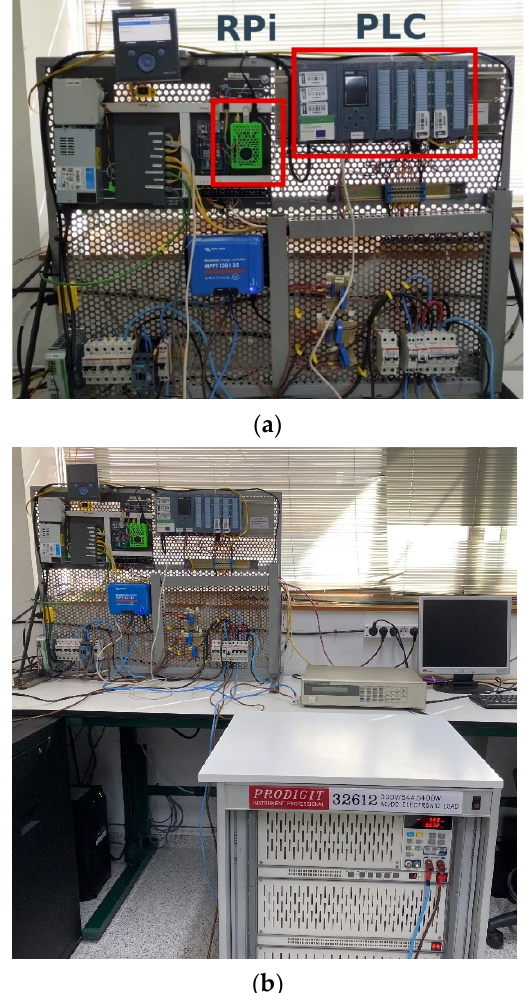
Figure 9. Setup in laboratory: ( a ) detailed view of curve tracer; ( b ) entire view including the programmable load.